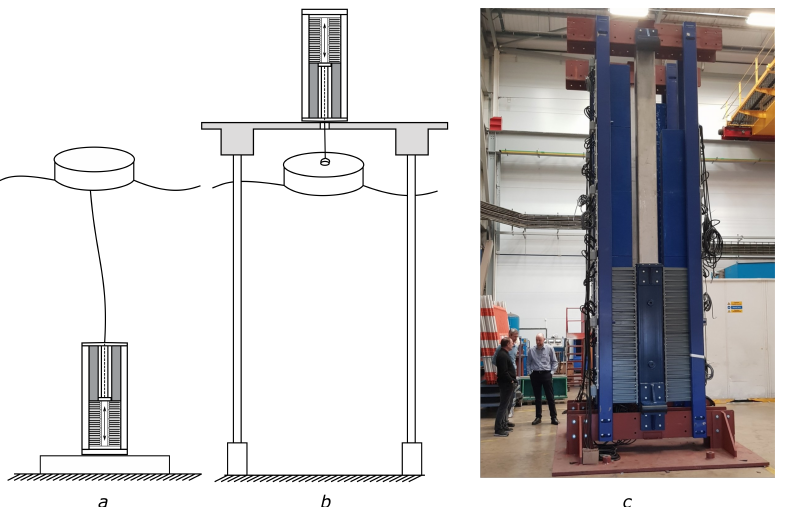
Figure 1. The two WEC concepts and the C-GEN linear generator: ( a ) a schematic illustration of the slack connection; ( b ) a schematic illustration of the stiff connection; ( c ) an image of the C-GEN linear generator during construction at Quartz Elec, Rugby, UK. The translator with the embedded magnets aligns with the white vertical guide in the middle of the device, the stator coils are potted in blue epoxy and are placed between the translator